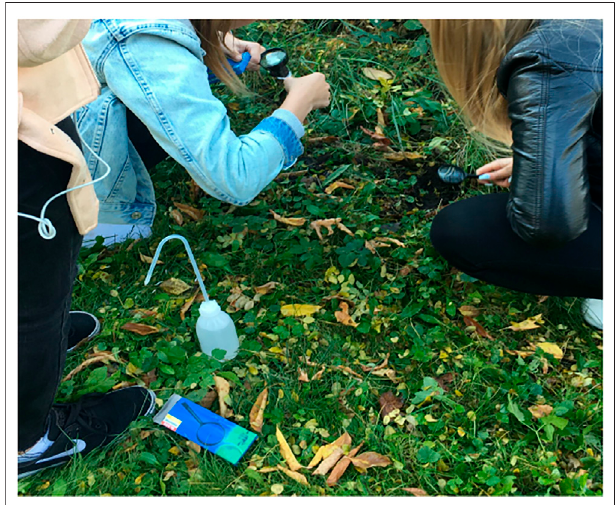
FIGURE 1 | The SDL data gathering activities